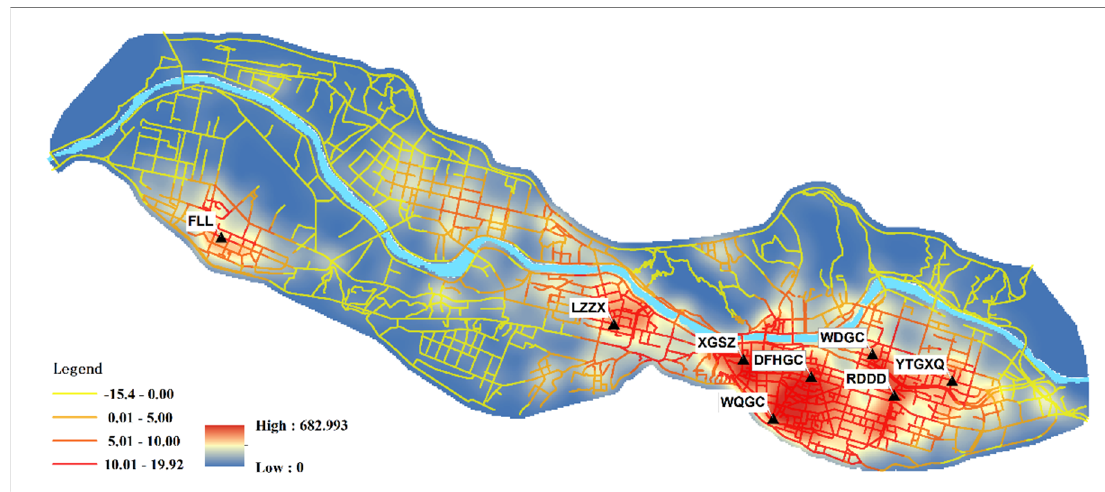
Figure 5. Spatial Distribution Characteristics of Vitality. Note: FLL = Fuli Road, LZZX = Lanzhou Center, XGSZ = Xiguan Cross, DFHGC = Dongfang Hong Square, WQGC = Wuquan Square, RDDD = Ruide Avenue, WDGC = Wanda Mall, YTGXQ = Yan Tan High-Tech Zone.